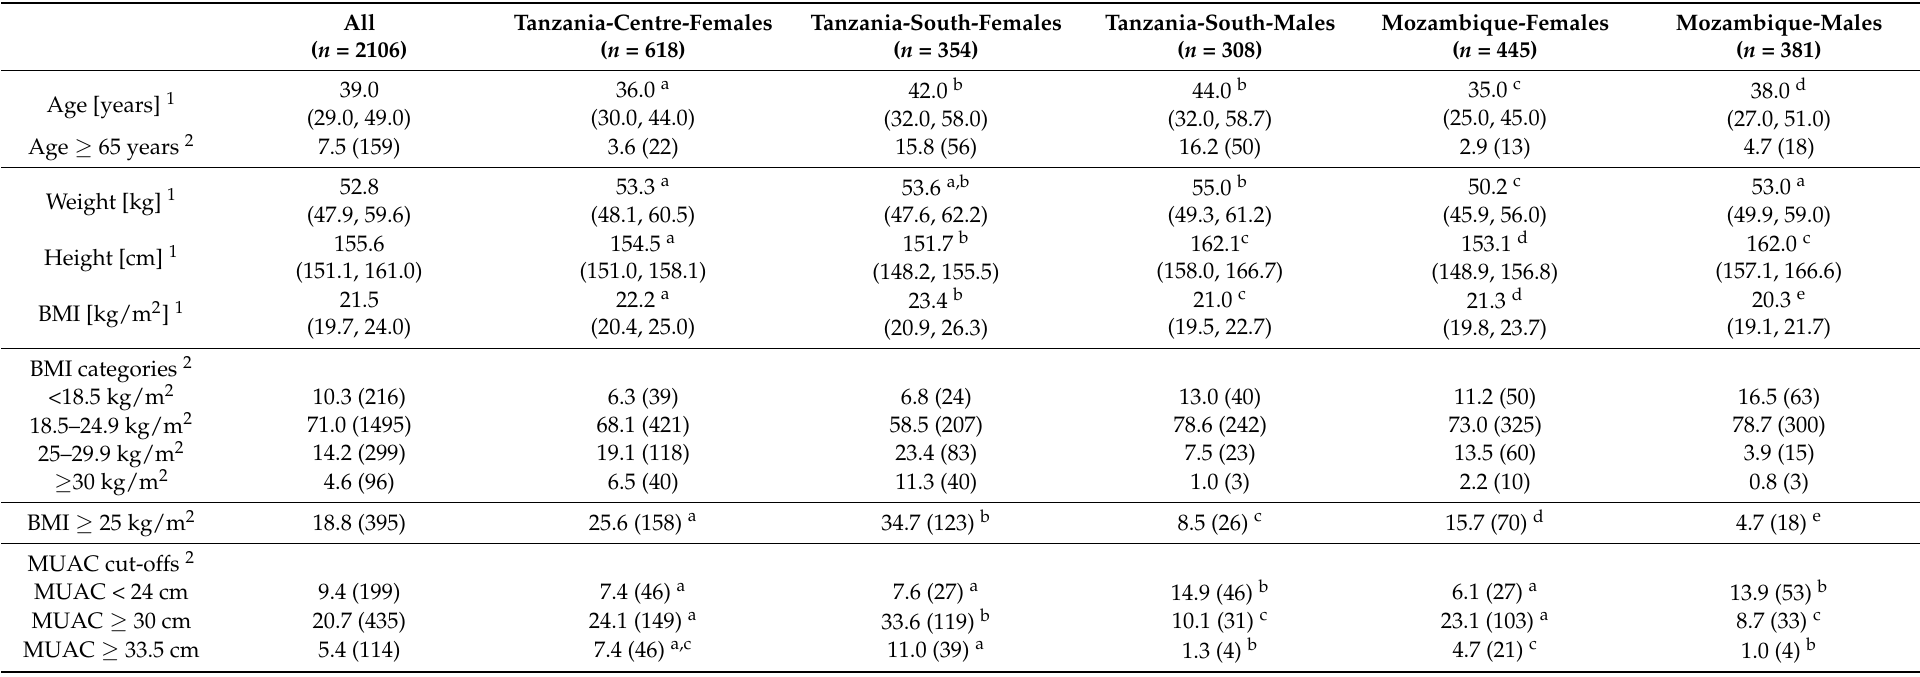
Table 1. Characteristics and anthropometrics of the farmers during baseline